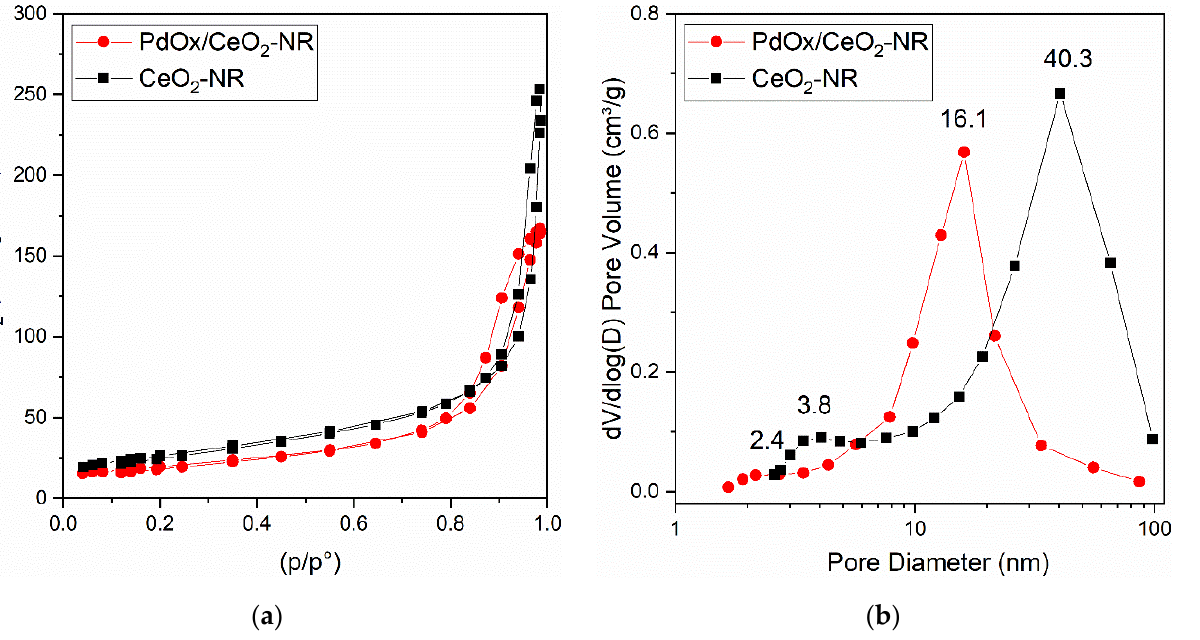
Figure 3. Brunauer–Emmet–Teller (BET) analysis of the CeO 2 -NR and PdO x /CeO 2 -NR samples: ( a ) nitrogen adsorption–desorption isotherms as a function of the relative pressure p/p°; ( b ) Barrett– Joyner–Halenda (BHJ) pore size distributions (PSD).